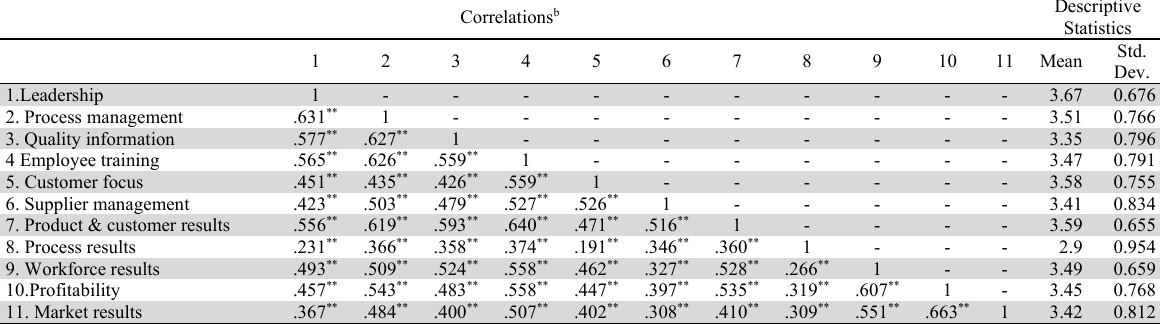
Descriptive statistics, bivariate correlations for variables in research model